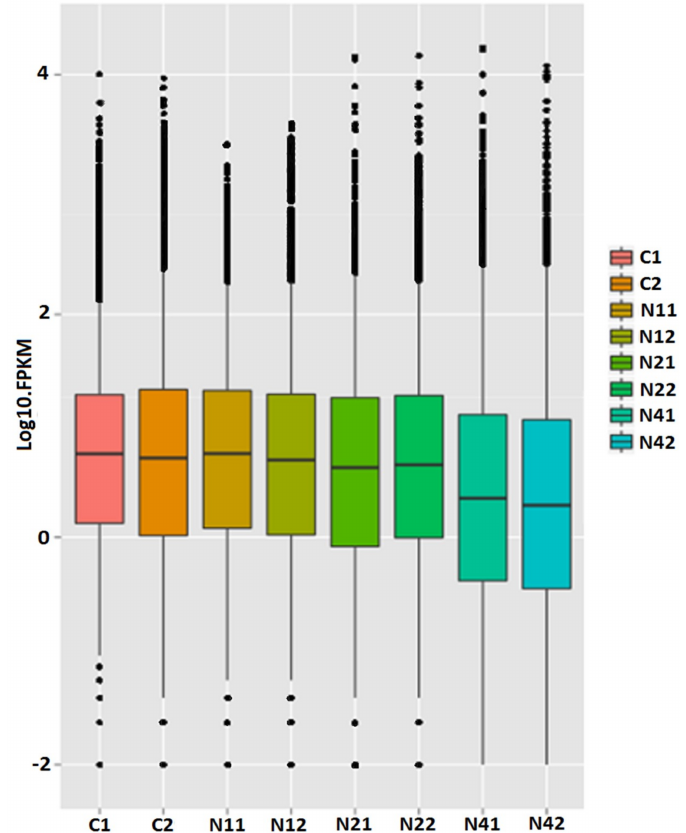
Figure 2. The box plot of FPKM in gene expression levels. Abscissa for sample name, ordinate for Log10.FPKM, box plot for each region for five statistics (From top to bottom: maximum, upper quartile, median, lower quartile and minimum), the outlier is shown in black